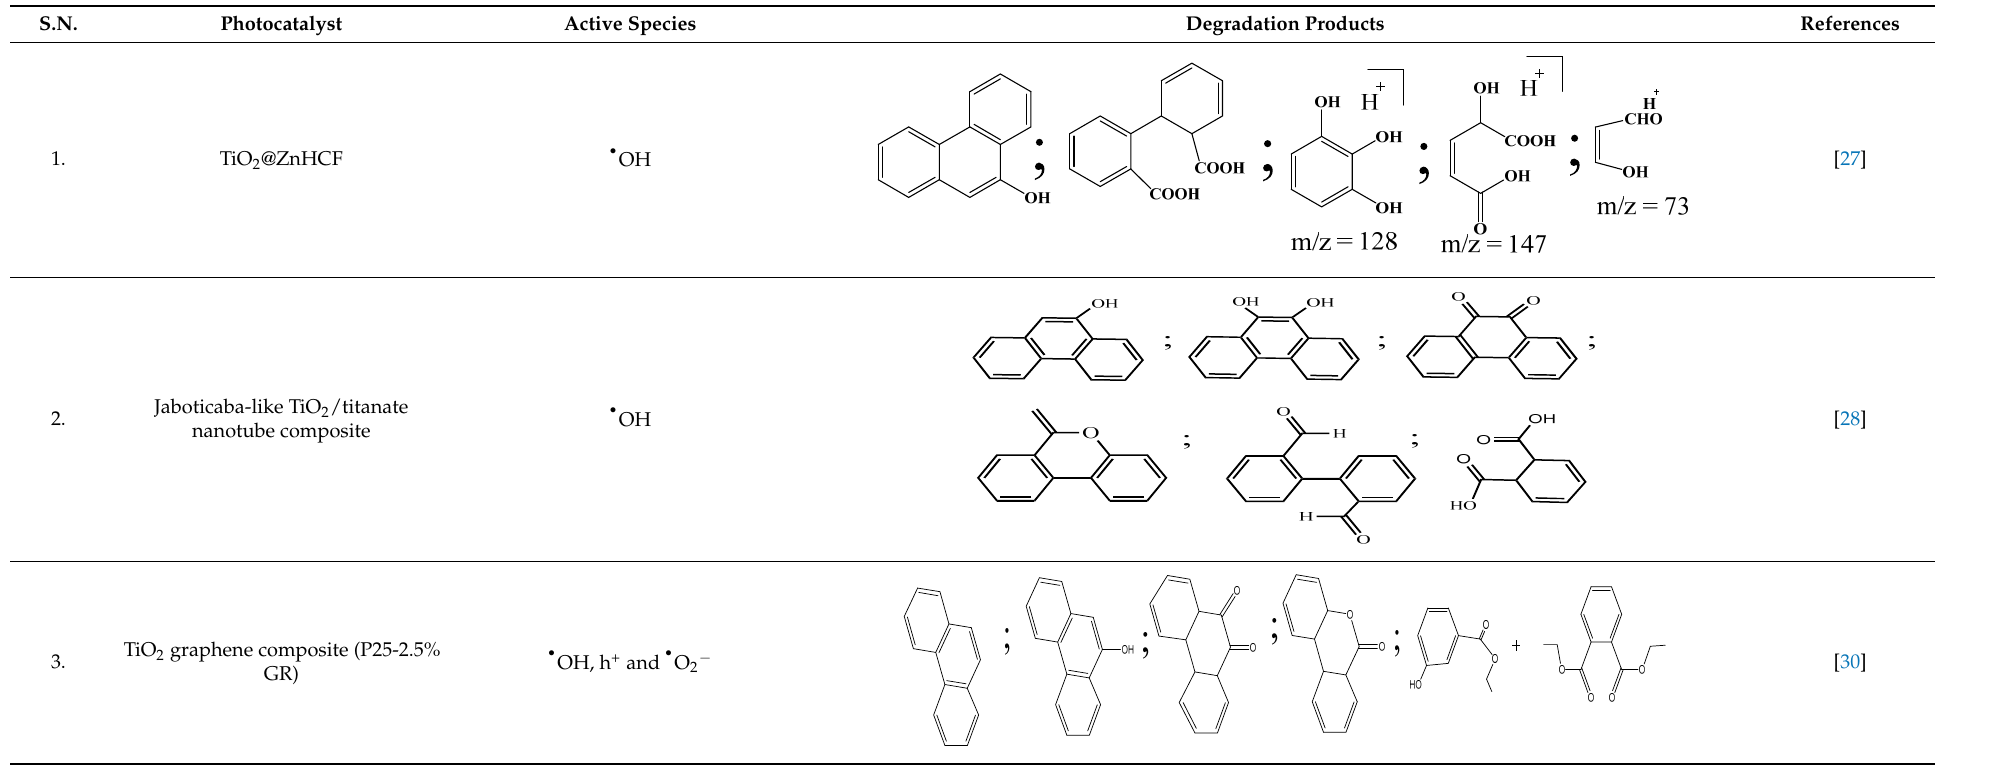
Table 2. Degradation products of phenanthrene by different catalysts.